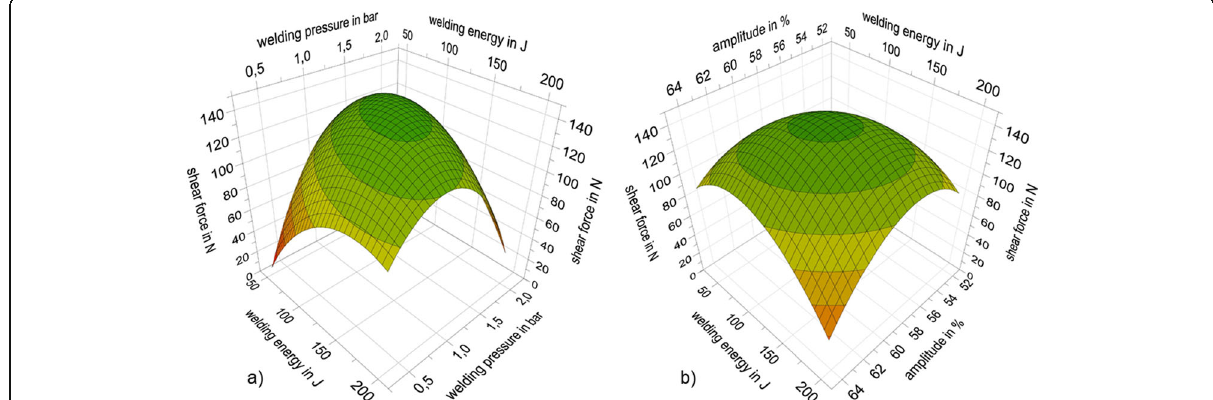
Fig. 7 Maximum shear force of 316L/Nd 2 Fe 14 B joints depending on the combination of a welding energy and pressure at an amplitude of 56%/ 14 μ m and b amplitude and welding energy at a welding pressure of 1.55 bar